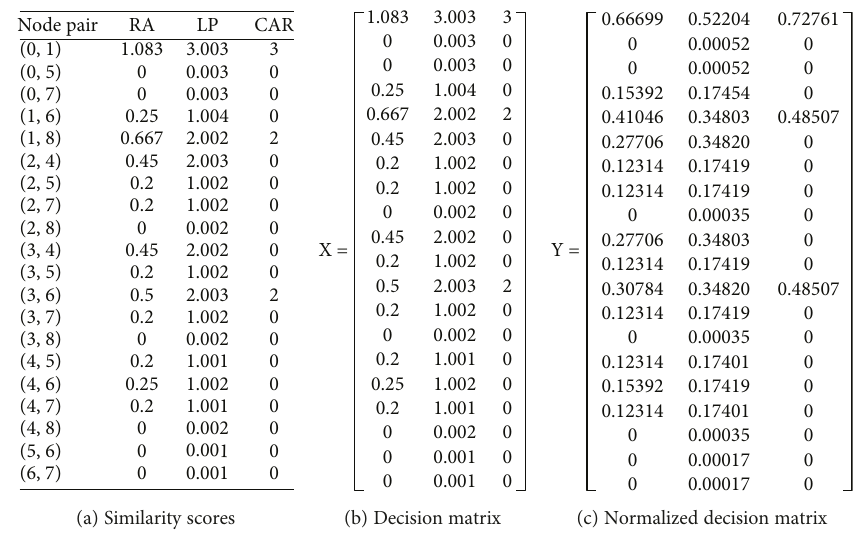
Figure 3: The values of RA , LP , and CAR for unconnected node pairs in the example network. Table 1: Relative closeness and rank of each node pair. Node